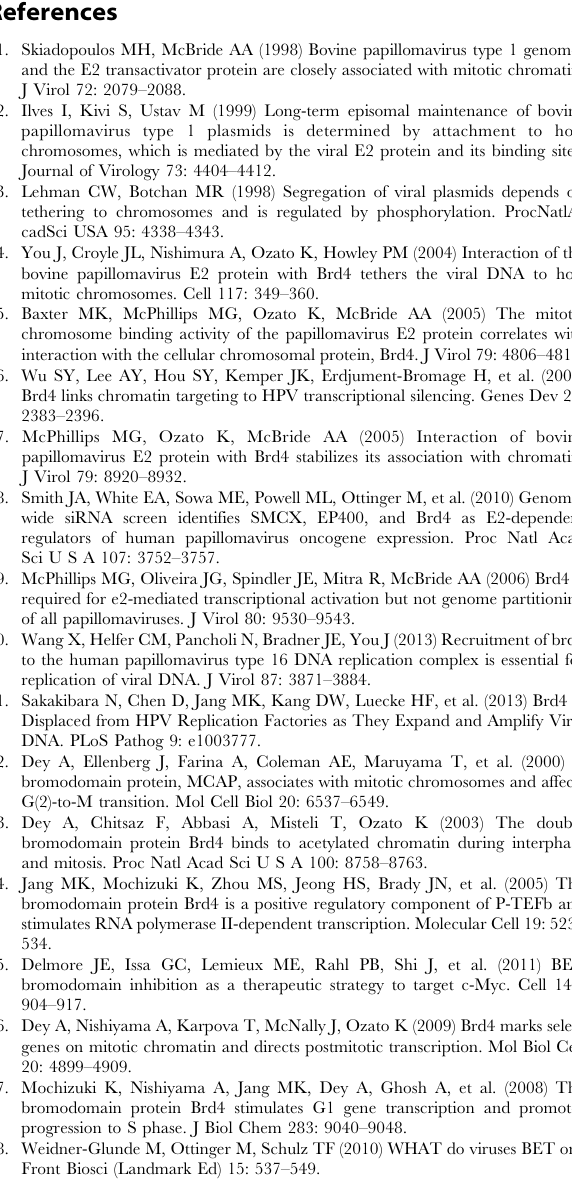
Table S4 List of E2, BRD4, Histone binding sites used for analysis in Figure 4B. Table S5 List of BRD4, FancD2, 16E1 binding sites used for analysis in Figure S7. Table S6 List of specialized FRA site coordinates used for analysis in Table 1. Table S7 List of HPV breakpoints used for analysis in Table 3. Table S8 List of antibodies. Table S9 List of Q-PCR